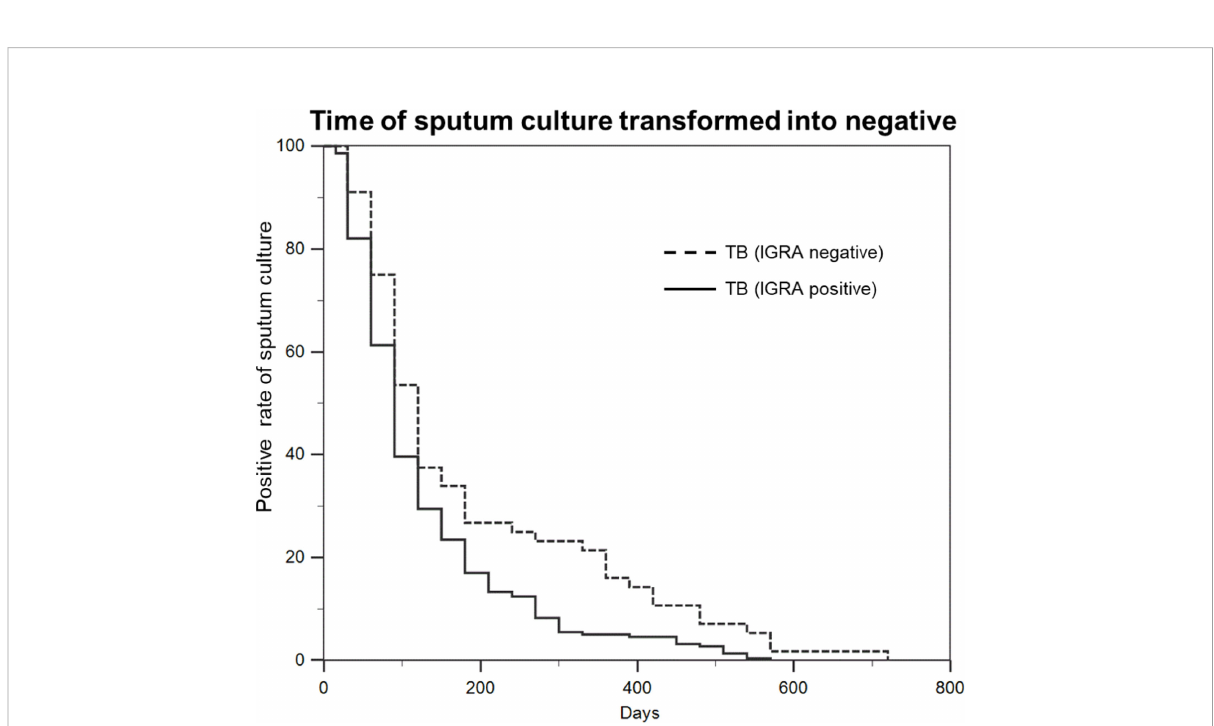
FIGURE 5 Patients with negative IGRA have a conversion to culture-negative status longer than those with positive IGRA. Statistical analysis of the time of sputum culture transformed into negative between TB (IGRA positive) group and TB (IGRA negative)